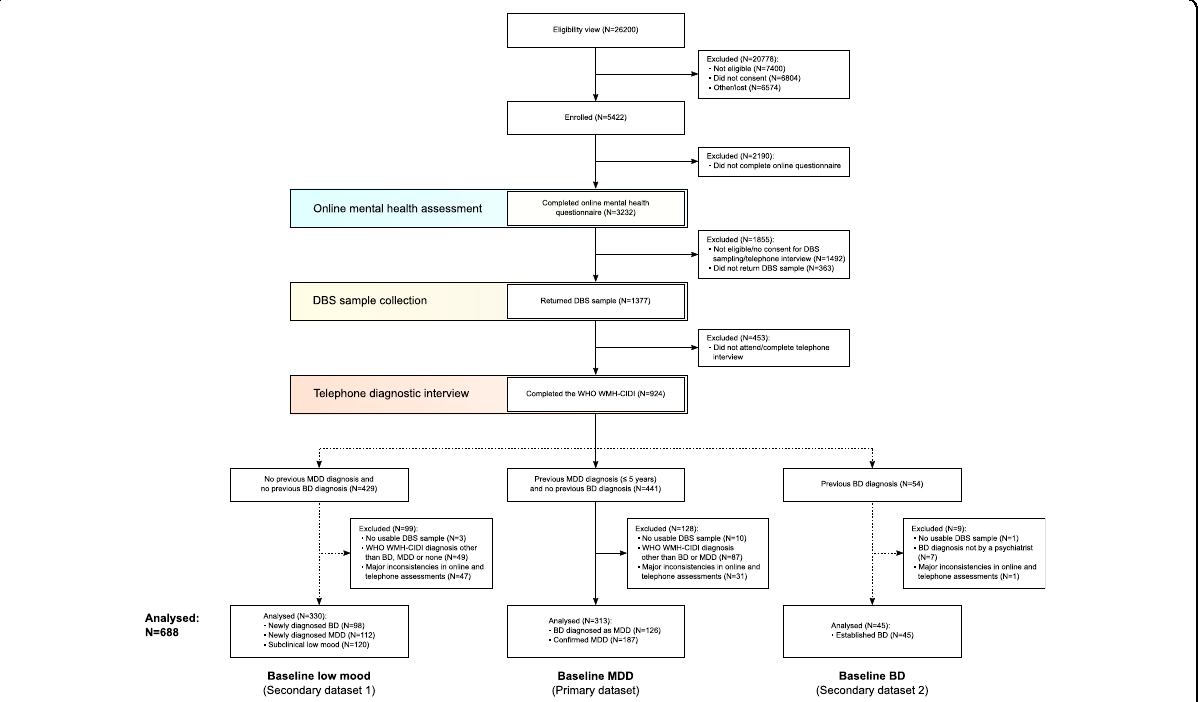
Fig. 1 Delta Study fl ow diagram. The diagram shows the number of individuals who completed each step of the study and reasons for attrition. BD bipolar disorder, DBS dried blood spot, MDD major depressive disorder, WHO WMH-CIDI World Health Organization World Mental Health Composite International Diagnostic